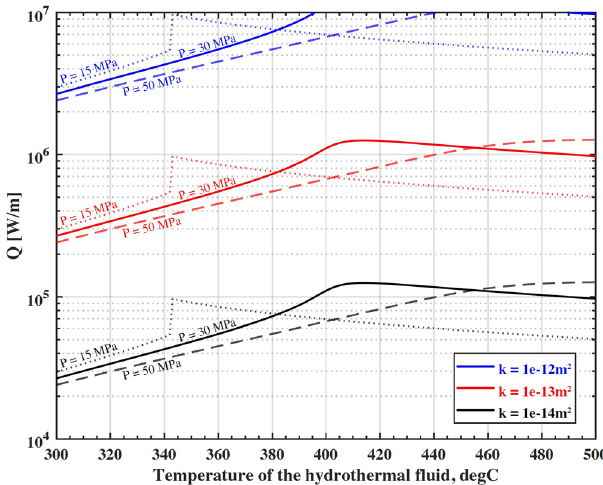
Fig. 6 Heat transported advectively by a hydrothermal fl uid of temperature T f for a given permeability k (line colors). Lines were computed from the Eq. (4) (i.e., Eq. (6) of Driesner 66 ), using a width for the hydrothermal plume ( L D ) of 50 m and for fl uid properties at 15, 30, and 50 Mpa shown as dotted lines, solid lines and dashed lines,